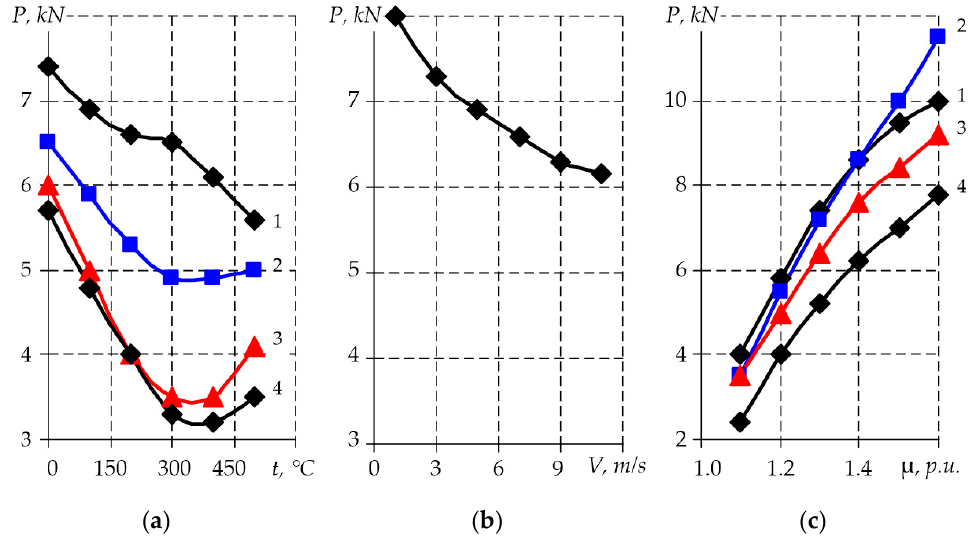
Figure 4. Dependencies Between Metal Pressure on Roll and Semifinished Rolled Product Temperature ( a ), Rolling Speed ( b ), and Single Drawing ( c ) for Various Steel Grades.